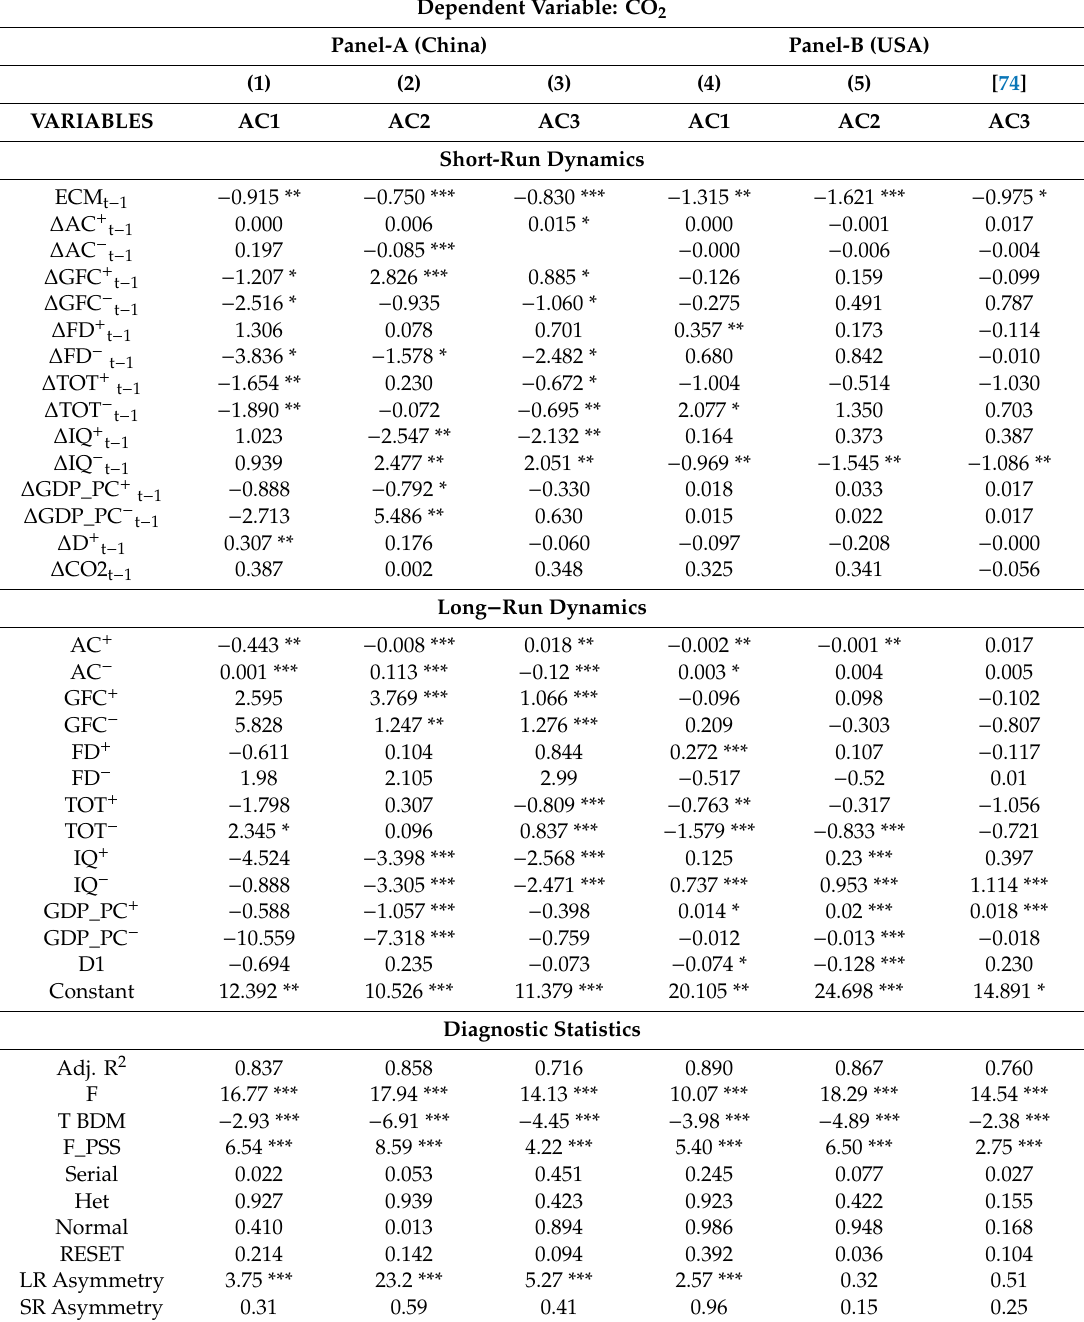
Table 4. Results of asymmetric impact absorptive capacity on CO 2